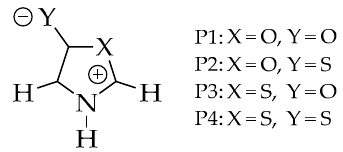
Figure 2. Structures of the investigated systems: Oxazoles ( P1 and P2 ) and thiazoles ( P3 and P4 ).